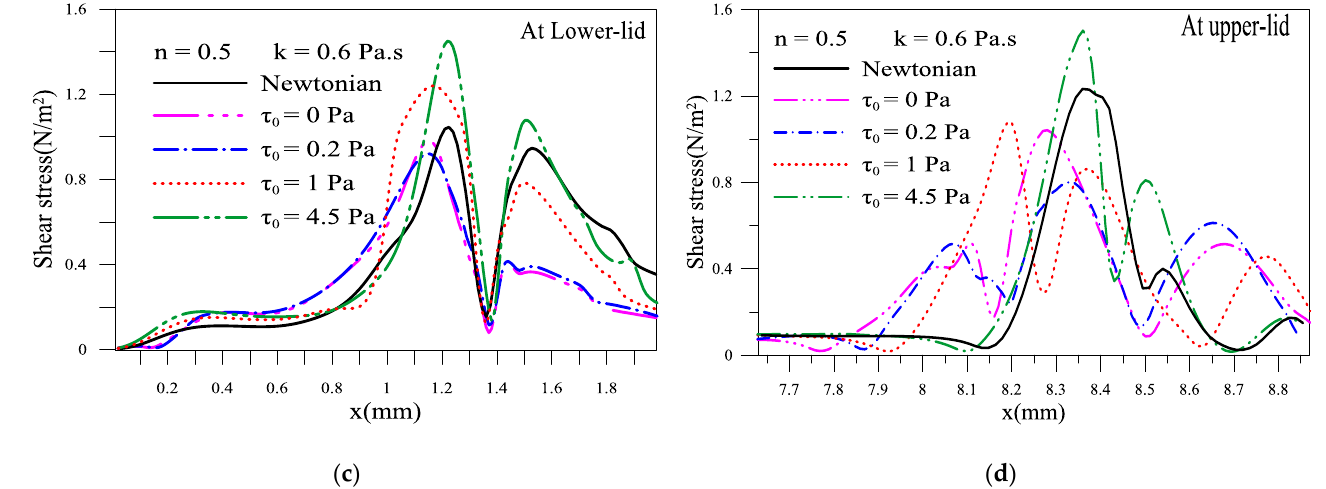
Figure 8. Variation of wall shear stress: ( a , b ) consistency k effect; ( c , d ) yield stress τ 0 effect.